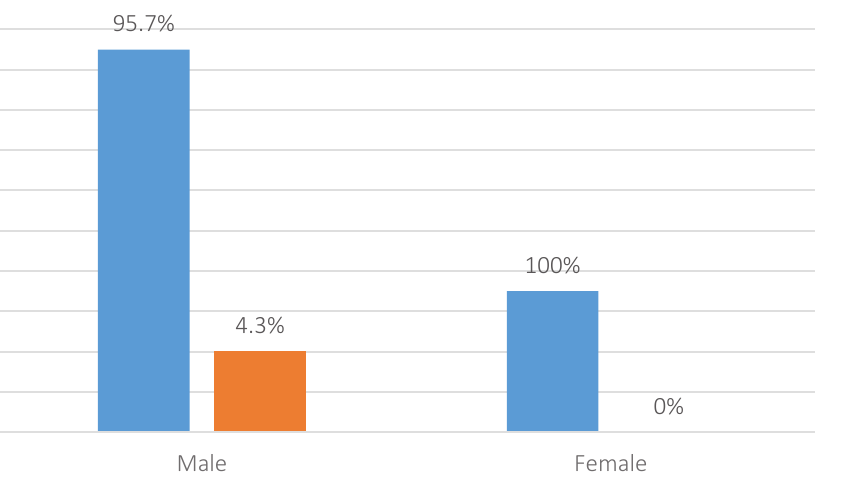
Figure A1. Awareness about eco-tourism